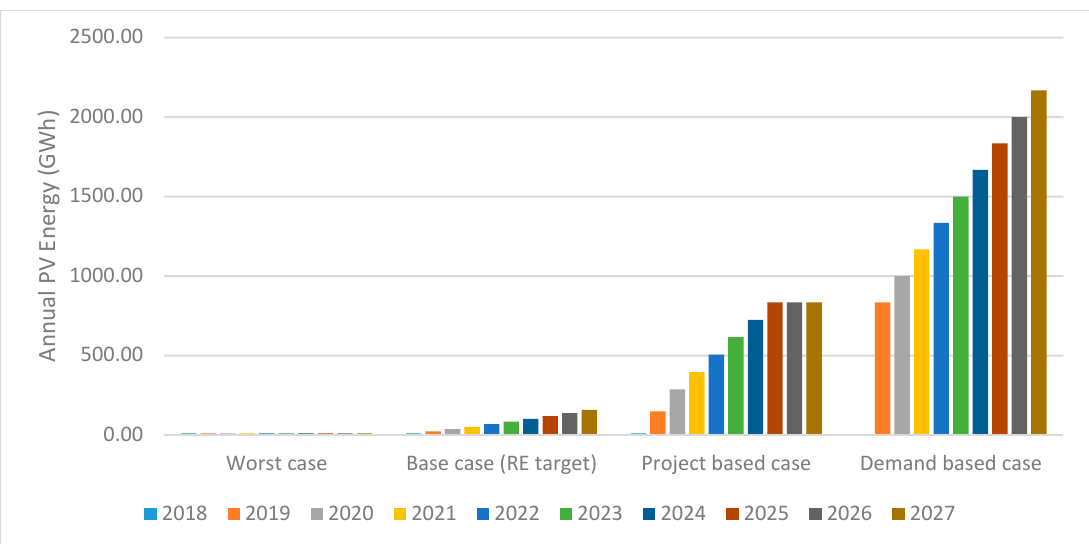
Figure 8. Forecast of annual required PV capacity according to the 4 scenarios.